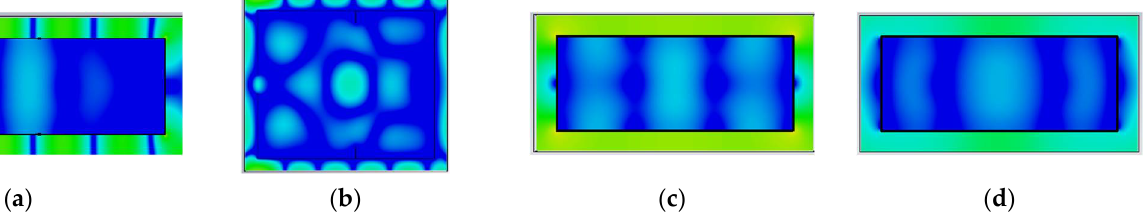
Figure 12. Mode303 field distribution of capacitive obstacles with a zero thickness value. ( a ) x section, ( b ) y section, ( c ) z section of the front part, and ( d ) z section of the back part.